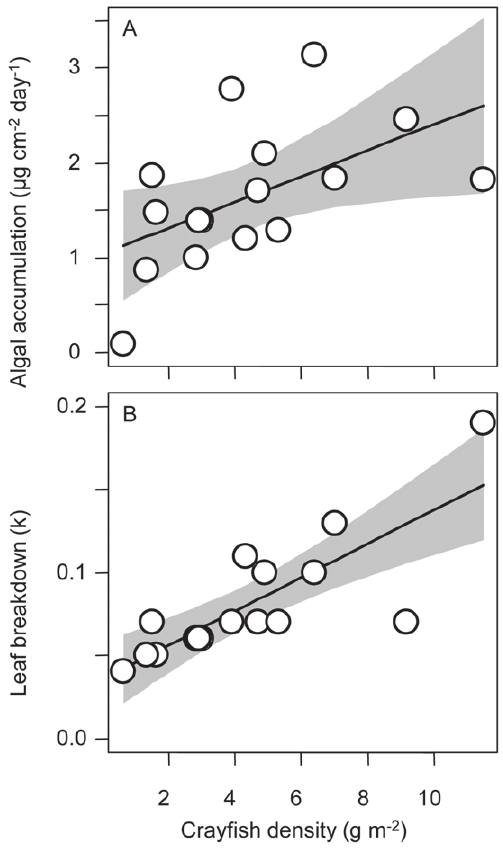
Figure 2. Ecosystem processes and crayfish density manipula- tion. Each point represents a study pool. (a). Rate of algal accrual on elevated tiles. Algal accrual was negatively associated with crayfish density (algal accrual rate=0.13 * crayfish + 1.05; R 2 =0.29, P =0.03). (b). Rate of breakdown of leaves. A higher k value corresponds to more rapid breakdown and k was higher at higher crayfish densities (k=0.010 * crayfish + 0.036; R 2 =0.64, P =0.0002). For both relationships, the solid line denotes the best fit linear model and the gray polygon indicates the 95% confidence interval.